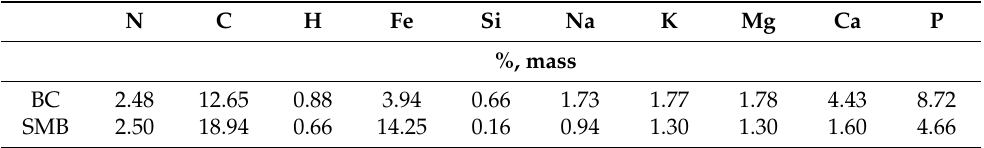
Table 1. Elemental composition of BC and